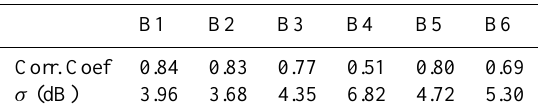
Fig. 6a. Comparisons between profiles of N 2 estimated from bal- loon data (grey line) and from radar echo power (black line) with a vertical resolution of 50m. The dashed and dot-dashed lines show N 2 profiles estimated from the meteorological balloon data at Hamamatsu (34.8 ◦ N, 137.7 ◦ E) and Yonago (35.4 ◦ N, 133.3 ◦ E), respectively, at a vertical sampling of 450m. The radar profile used the averaged pressure and temperature profiles measured by the closest (in time) meteorological radiosondes at Yonago and Hama- matsu around the MU radar site. Table 2. Cross-correlation coefficients and standard deviation of the difference M 2 r − M 2 for b